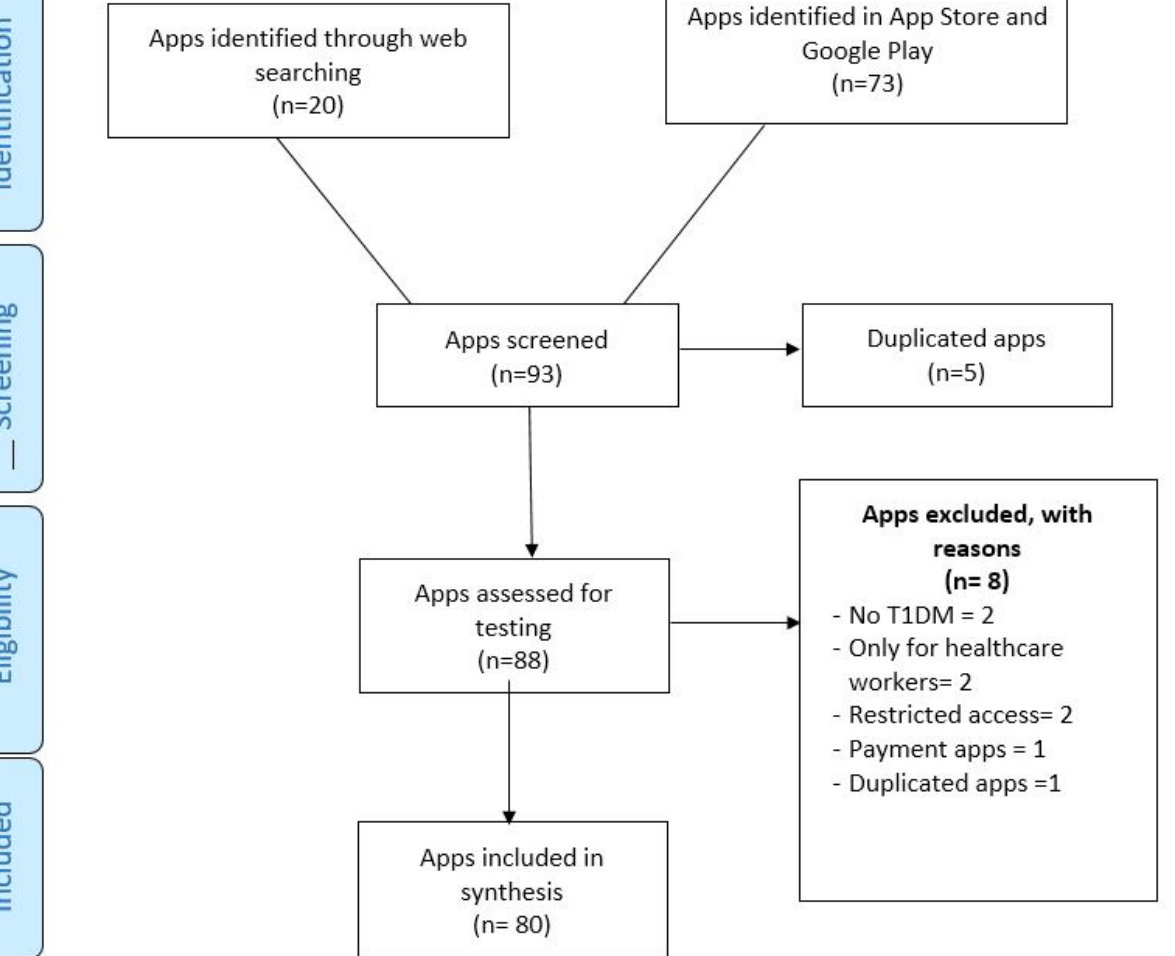
Figure 3. Selection of the available apps for type 1 diabetes management and